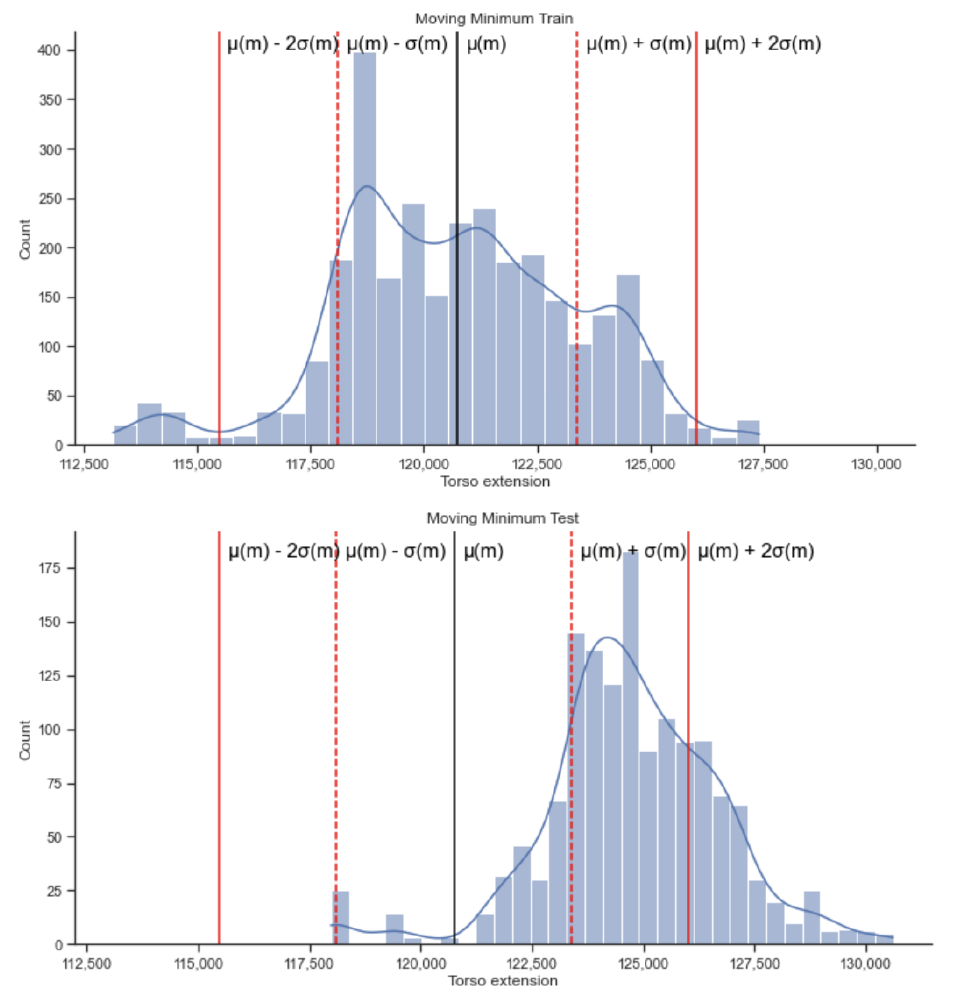
Figure 8. Distribution of training (sitting, walking) and testing values (running) for the moving minimum algorithm on the respiration signals for a participant when using the combined data (talking and not